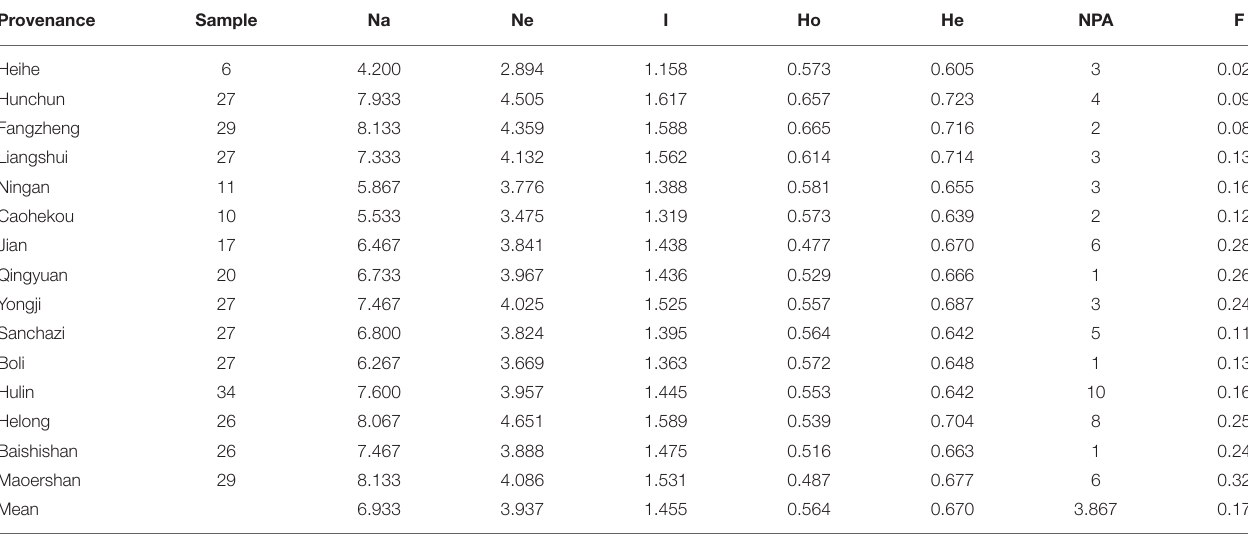
TABLE 4 | Genetic diversity parameters of different populations of J. mandshurica